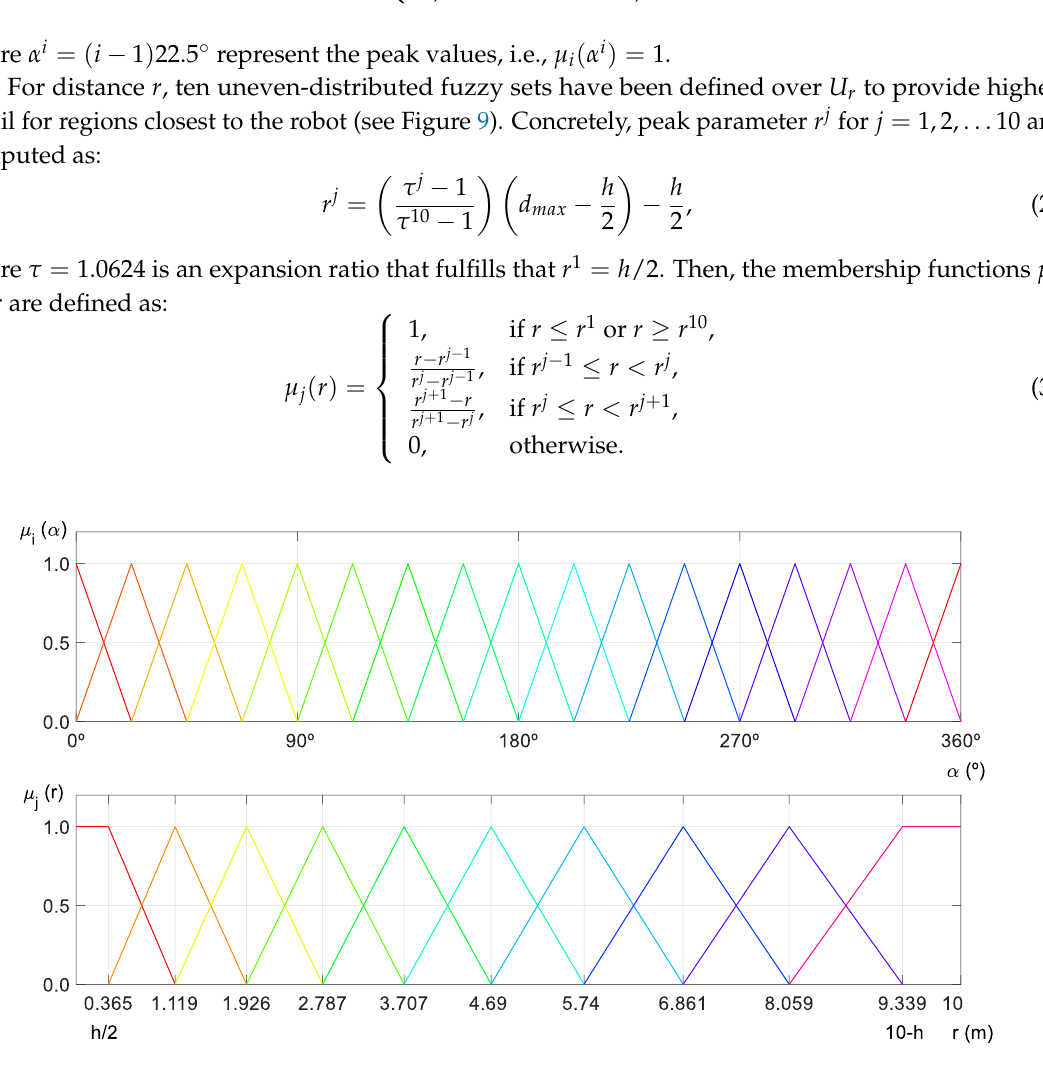
Figure 9. Membership functions for variables α ( top ) and r ( bottom